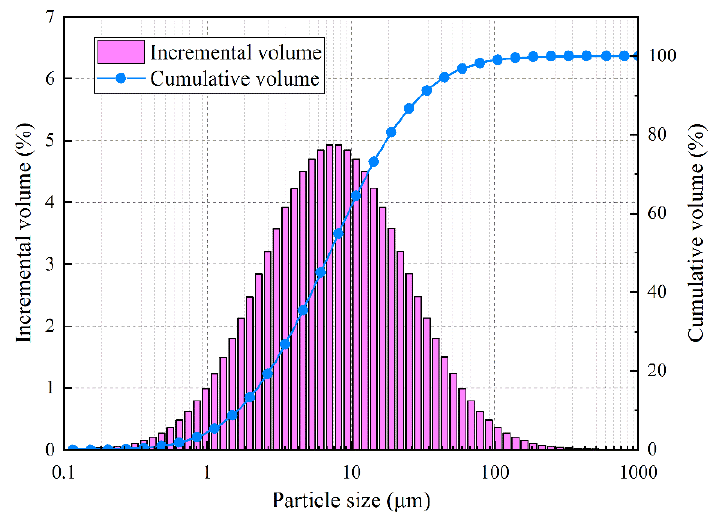
Figure 1. Particle size distribution of cement.